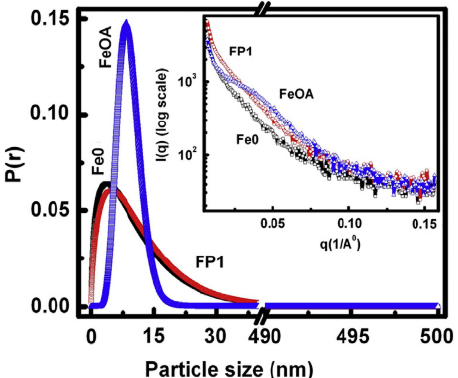
Figure 9. Probability distribution as a function of particle size, obtained from SAXS data, for FP1, FeOA and Fe0 magnetite nanoparticles. The inset shows the scattering intensity vs. q. The figure is reproduced with permission from Muthukumaran et al. [53].